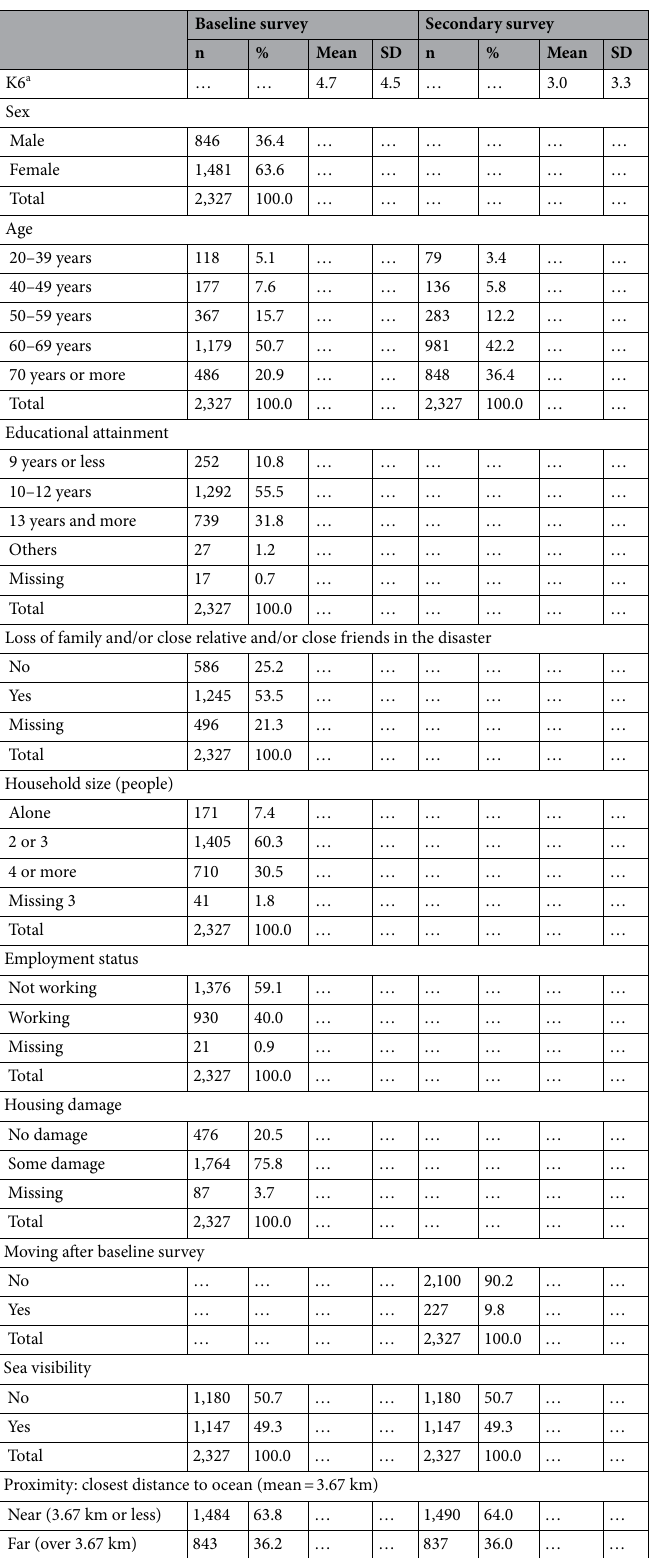
Table 1. Socio-demographic characteristics of study participants at baseline and secondary survey (n = 2,327). Mean represents averaged scores among the respondents. Empty cells at secondary survey due to time- invariant variables. SD, standard deviation. a Continuous